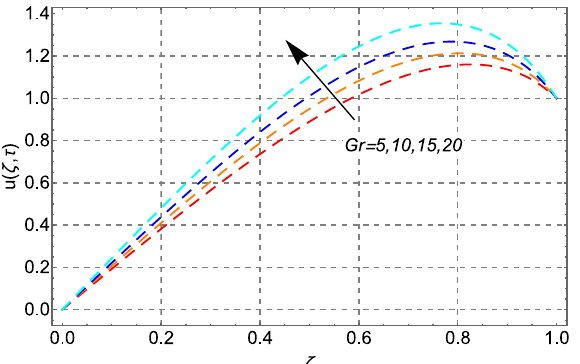
Figure 5. Impact of thermal Grashof number Gr on velocity distribution.